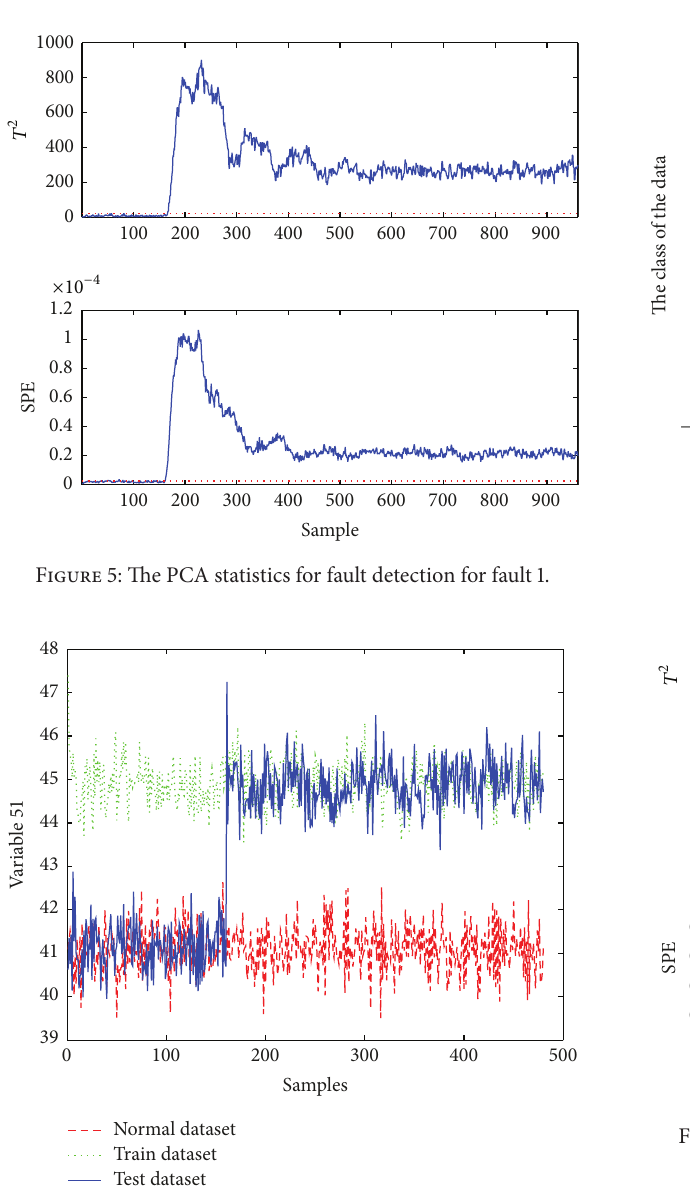
Figure 6: TE: plot of variable 51 in fault 4.